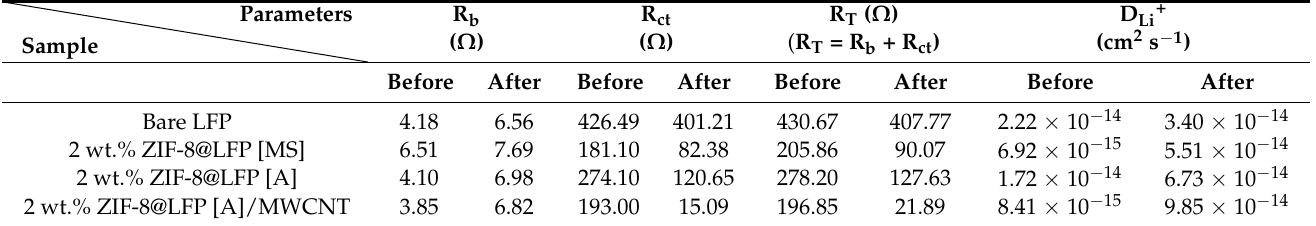
Table 2. Summary of the impedance parameters of the electrodes before and after high-rate performances.